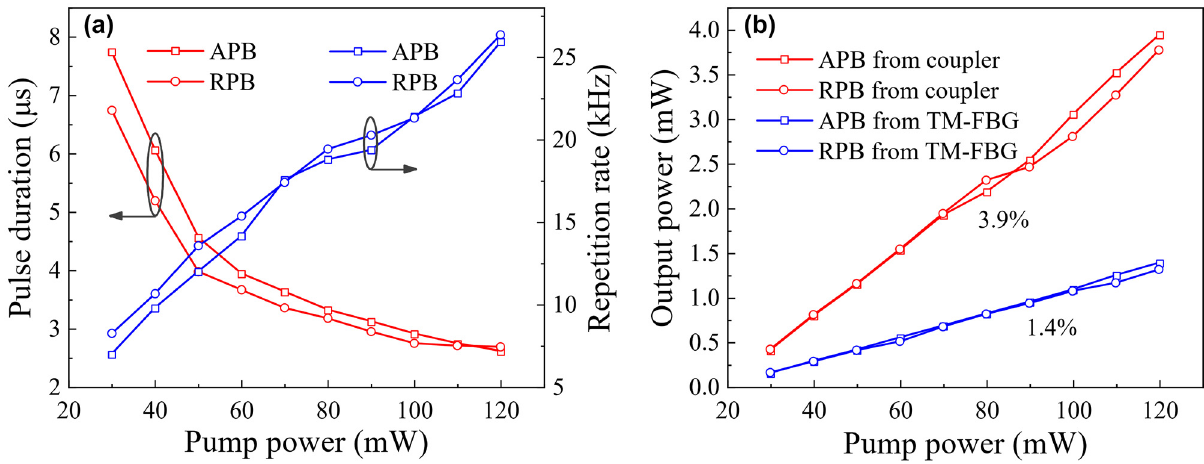
Figure 7: Evolution of the Q- switched CVB laser with pump power. (a) Pulse duration and repetition rate. (b) Output power from OC and